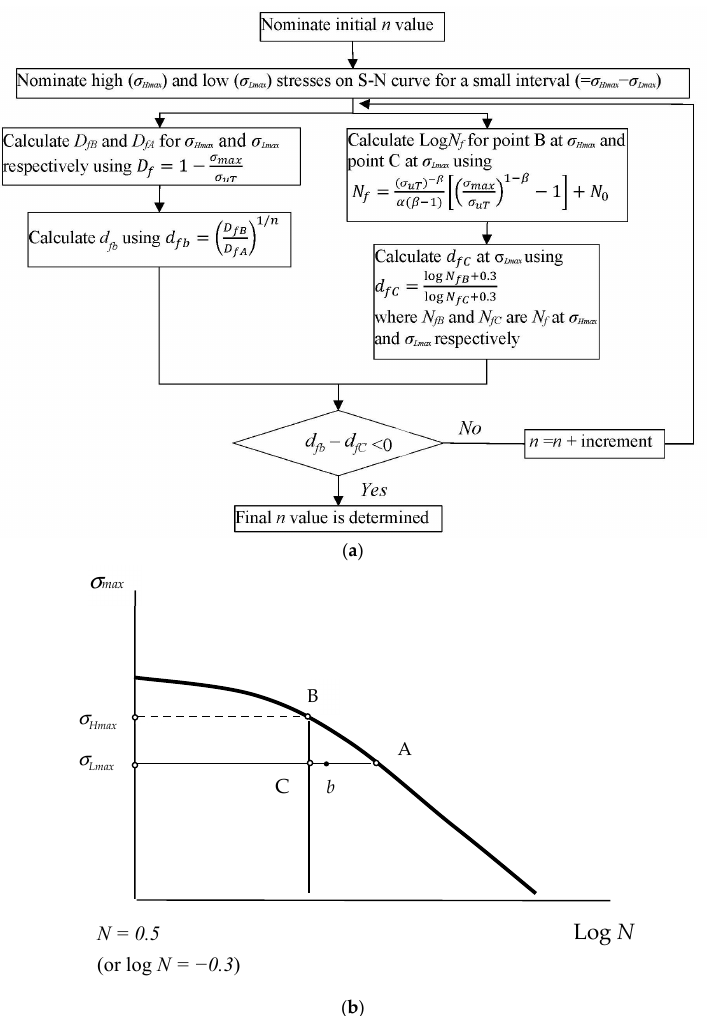
Figure A1. Calculation and notation: ( a ) sequence for finding exponent n value at given high ( σ Hmax ) and low ( σ Lmax ) stresses; and ( b ) notation on schematic S-N plane.